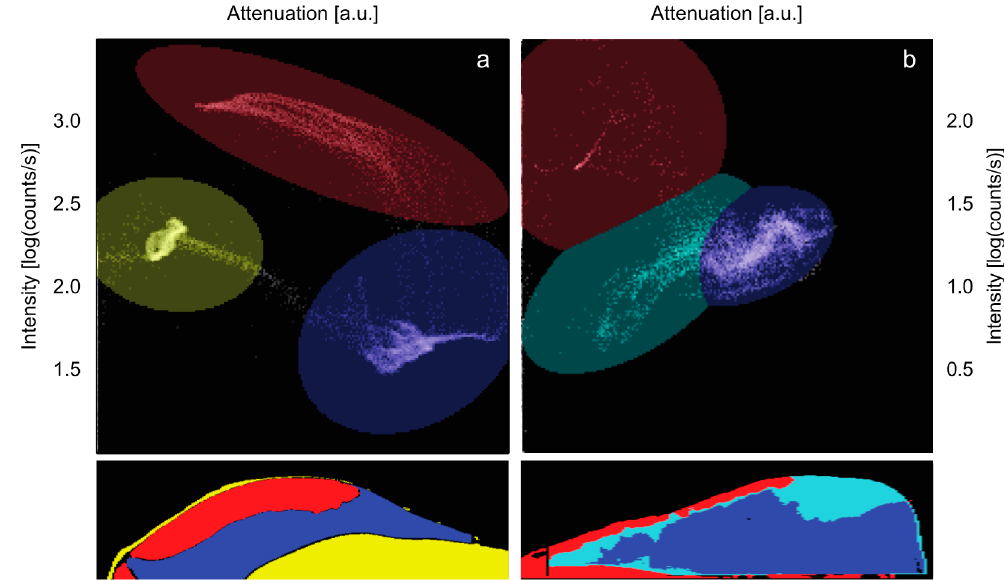
Figure 8. The bivariate histogram plots allow segmenting some anatomical features and identifying regions that belong to the carious and the unaffected enamel. ( a ) The red color indicates the lesions, blue color is associated with the unaffected enamel, and the yellow color corresponds to dentin. In the slice containing the artificial lesion ( b ), dentin is not correctly identified. Rather, it is associated with the lesions, whereas the thinned enamel is assigned to an independent component.